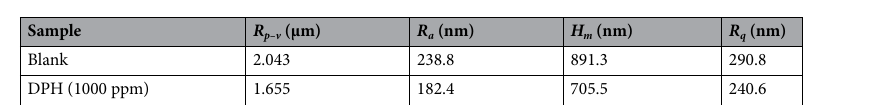
Table 7. Parameters obtained from the surface of MS immersed in 1 M HCl solution without and with 1000 ppm DPH after 4 h using AFM analysis.